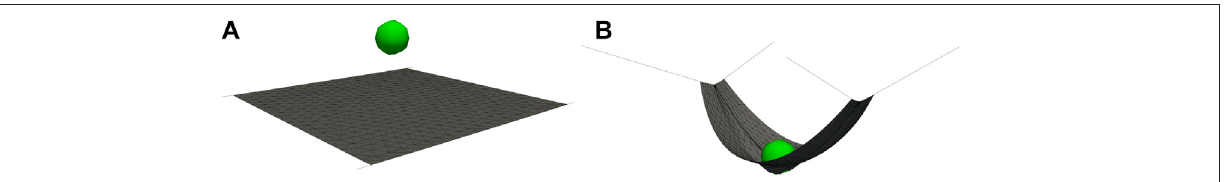
FIGURE 4 | Sliding cable elements on two opposing sides applying the tension fi eld theory, described by Nakashino and Natori (2005), to exclude compression stiffness from the plate in membrane fi nite elements. (A) Reference con fi guration, fi xed on four corner nodes. (B) Sliding cable element formulation allows for a sliding of the discrete element